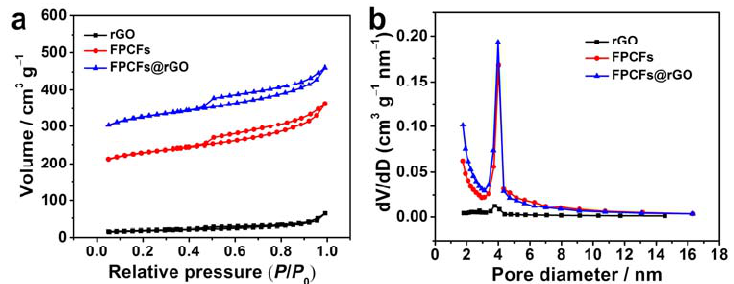
Figure 4. ( a ) Nitrogen adsorption–desorption isotherms and ( b ) pore size distributions of rGO, FPCFs, and FPCFs@rGO.